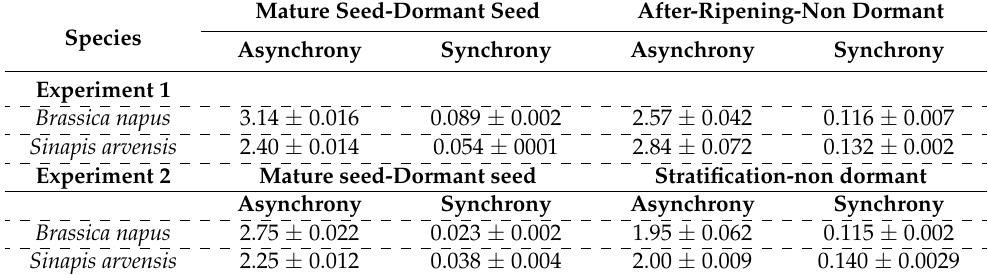
Table 1. Synchrony pattern of dormant and nondormant seeds.